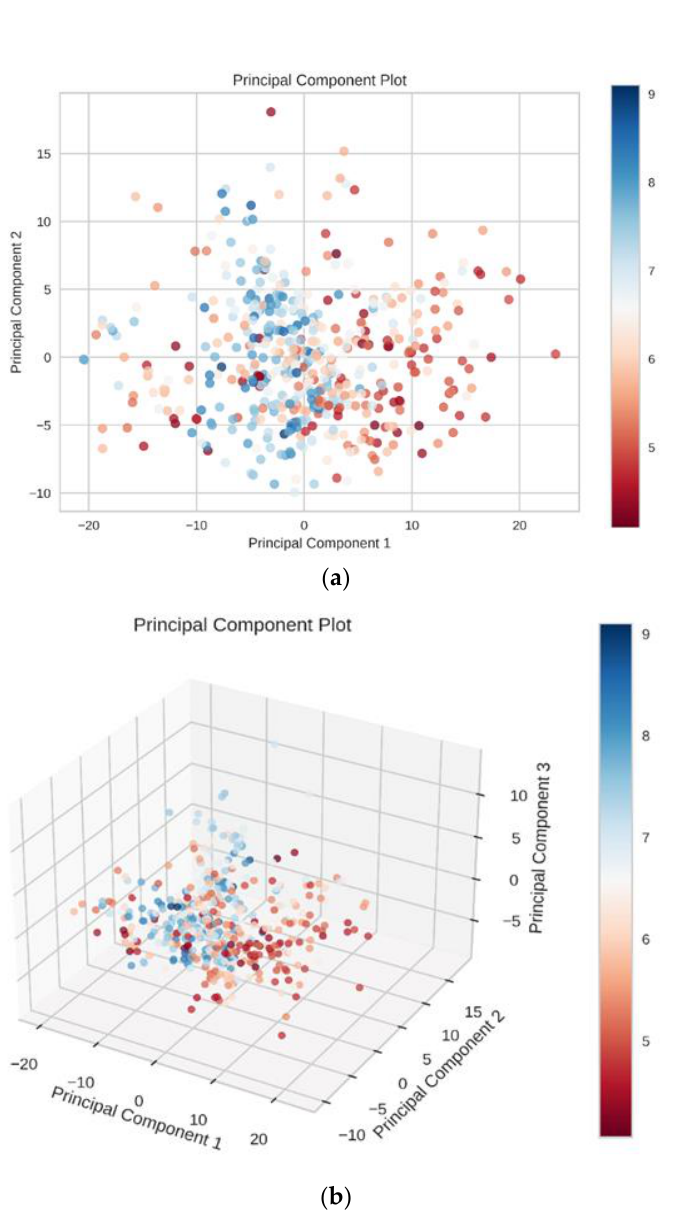
Figure 12. The results of the 2D principal component analysis ( a ) and the 3D principal component analysis ( b ).